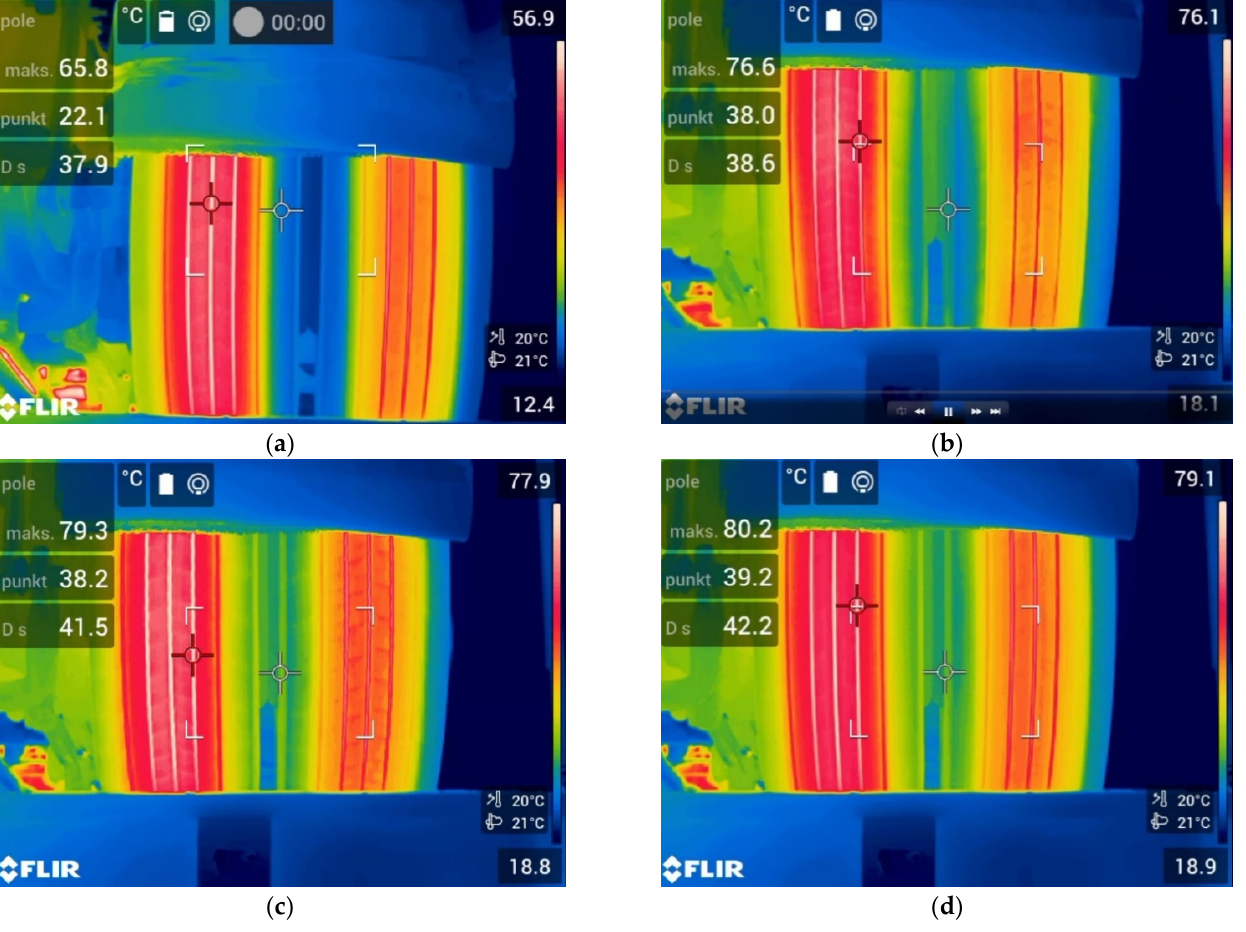
Figure 11. Tire temperature at the end of each test for axle load: ( a ) 20,000 N ( b ) 30,000 N ( c ) 40,000 N ( d ) 20,000 (warm tires) (authors’ source).